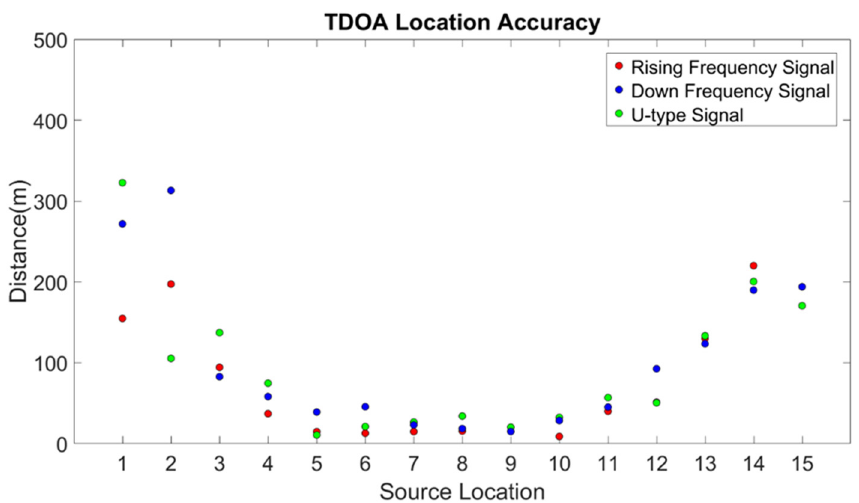
Figure 12. Distribution of localization errors.